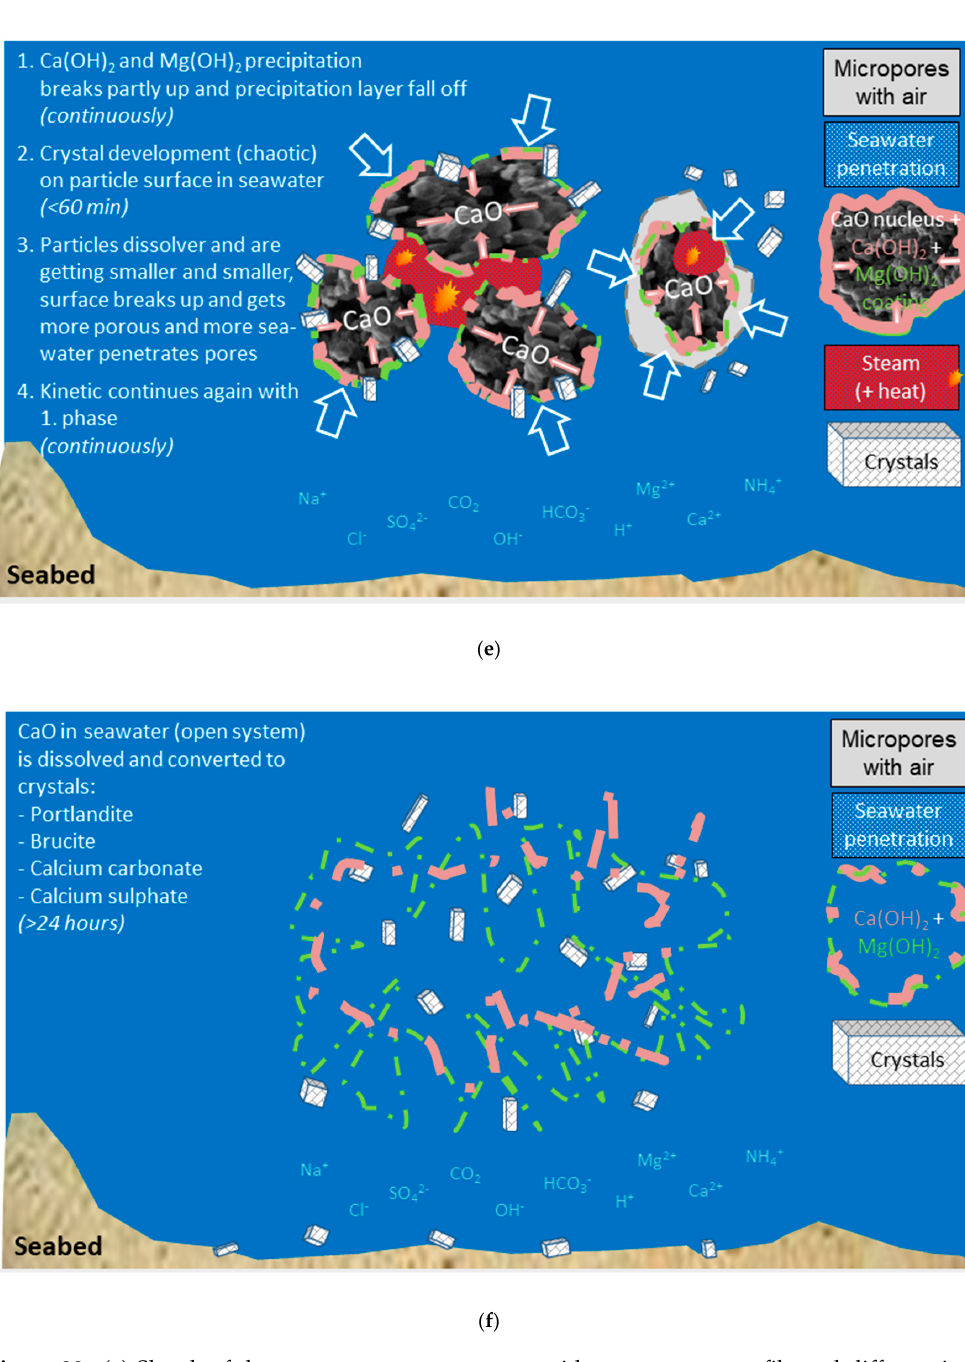
Figure 20. ( a ) Sketch of the «open system» sea water with temperature profile and different ions; ( b ) Sketch of an agglomerate of burnt lime particles; ( c ) Phase 1 : Immediate reaction between burnt lime and sea water—a surface layer of calcium hydroxide is formed; ( d ) Phase 2 : The surface reaction forming calcium hydroxide continues and magnesium hydroxide is precipitated; ( e ) Phase 3 : Structural compression and formation of crystals; ( f ) Phase 4 : All burnt lime particles are completely reacted and transformed to other